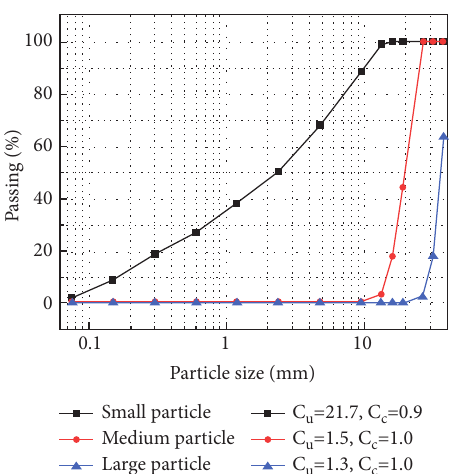
Figure 2: Sieving test of different